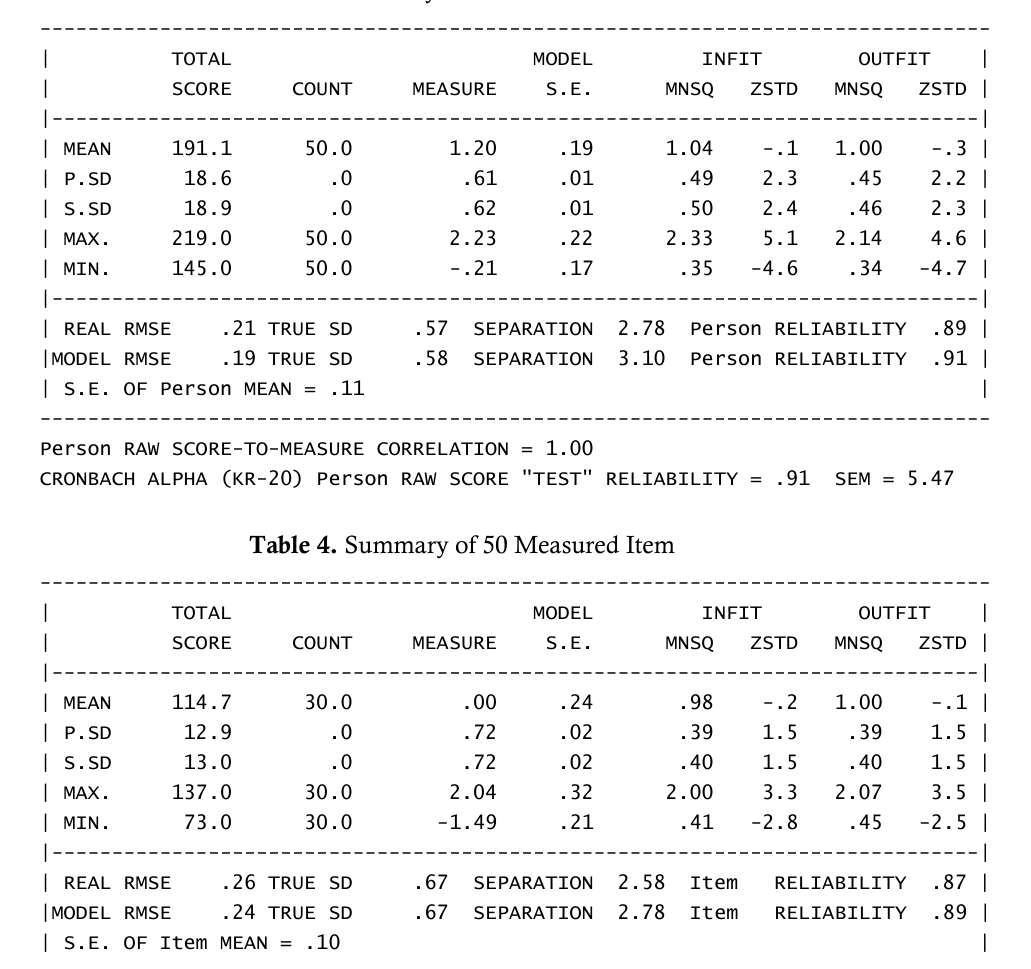
Table 3. Summary of 30 Measured Person